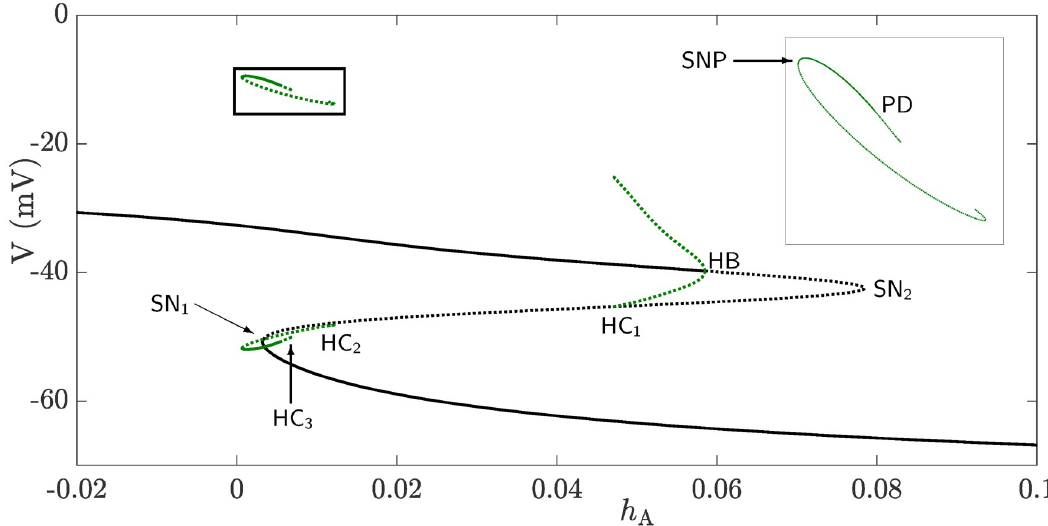
Fig 10. Bifurcation diagram of the fast subsystem, represented by the membrane voltage V , when h A is varied as a parameter and Ca is kept fixed at a random but physiologically-relevant value of 0.2 μ M. The Z-shaped curve (black) is the branch of equilibria of the fast subsystem consisting of three branches separated by two saddle-node bifurcations, denoted SN 1 and SN 2 . The solid and dotted black lines indicate stable and unstable branches of equilibria, respectively. The lower and middle branches are of stable and saddle type, respectively. The upper branch is stable for lower values of h A and becomes unstable (of saddle type) at a subcritical Hopf bifurcation, denoted HB , where an envelope of unstable periodic orbits emanates and terminates at a homoclinic bifurcation ( HC 1 ). An isolated envelope of periodic orbits comprised of an upper and a lower � -shaped loop exists near h A -values of SN 1 . The isolated envelope has an inner envelope of unstable periodic orbits that terminates at a homoclinic bifurcation ( HC 2 ) to the right, but undergoes a saddle-node bifurcation of periodic orbits ( SNP ) to the left, forming a stable outer envelope. As shown in the inset, this envelope becomes unstable at a period doubling bifurcation ( PD ) and terminates to the right at another homoclinic bifurcation, denoted HC 3